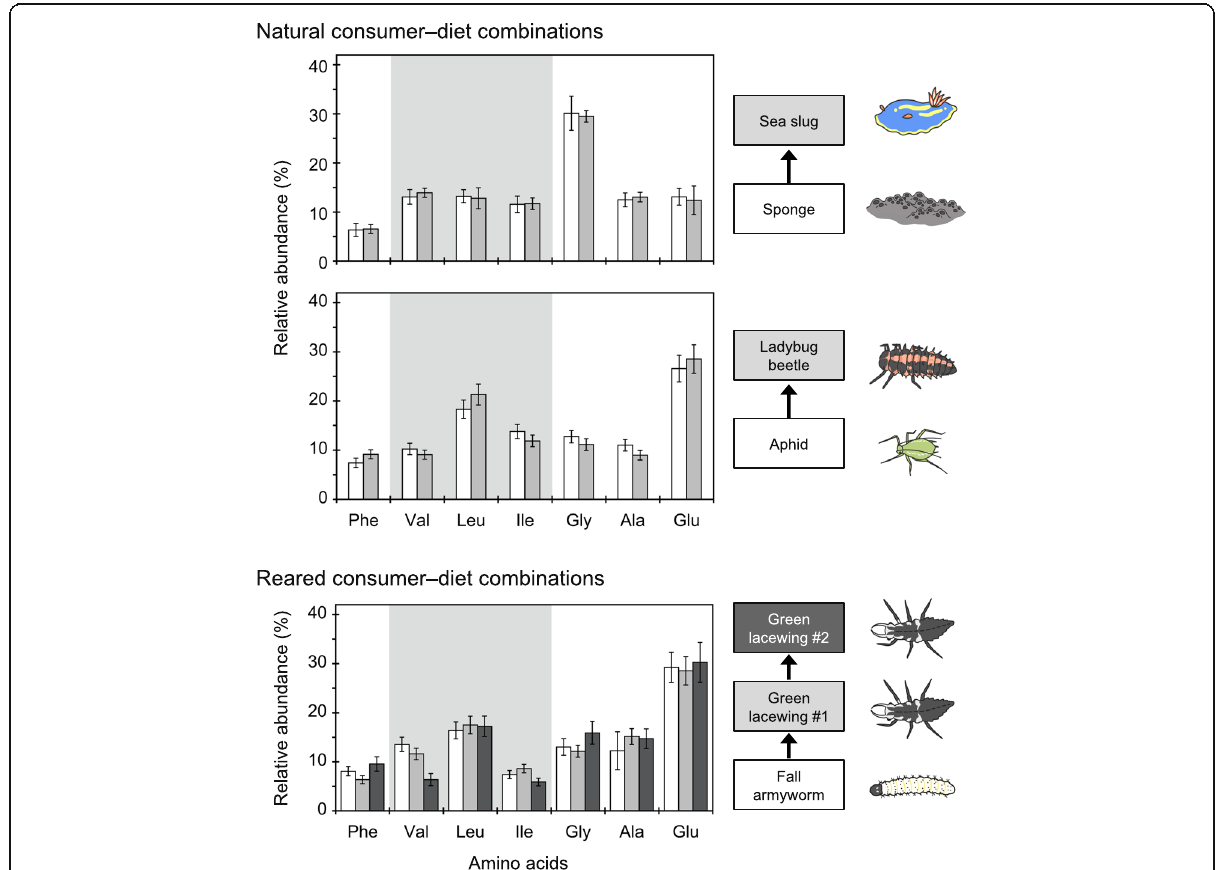
Fig. 1 Molar balance of amino acids for four combinations of consumer and diet. Error bar indicates standard deviation (1 σ ) of replicate measurements